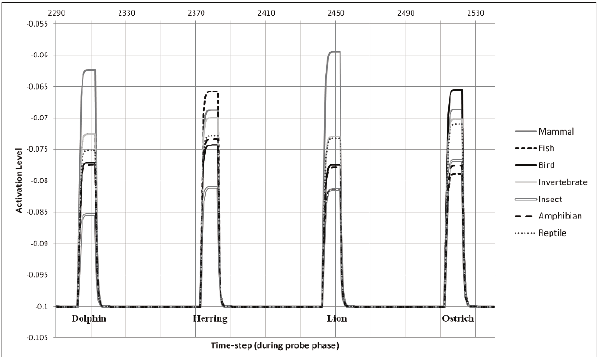
Figure 4. Example activation profiles for the ‘Animal Class’ property during the probe phase of one DAIM run, showing four probes (the properties of Dolphin, Herring, Lion and Ostrich). ‘Resting’ activation level is -0.1; rising activity is due to activation spread on the substrate of created associations between properties. Steady-state activation levels re- main constant for at least 3 time-steps. These activation levels are normalised for the